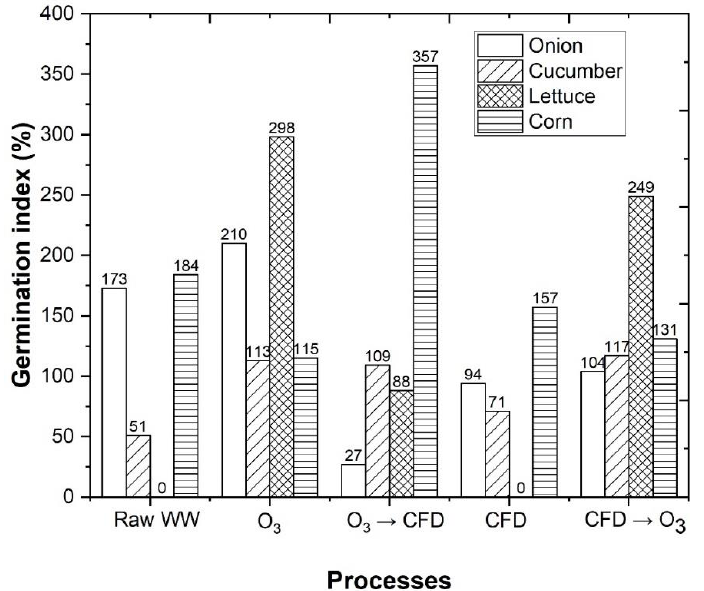
Figure 11. Analysis of germination index (GI) regarding the germination of onion, cucumber, let- tuce and corn after ozonation (O 3 ), coagulation – flocculation – decantation (CFD) and combined O 3 → CFD and CFD → O 3 treatments. The following CFD operational conditions were used: 0.48 g/L potassium caseinate, 0.52 g/L bentonite, pH 4.0, temperature 298 K, rapid mix 150 rpm/3 min, slow mix 20 rpm/20 min, sedimentation time 12 h. The following O 3 /Fe 2+ /UV-C experimental conditions were used: pH = 4.0, [Fe 2+ ] = 1.0 mM, ozone flow rate 5 mg/min, air flow 1.0 L/min, agitation